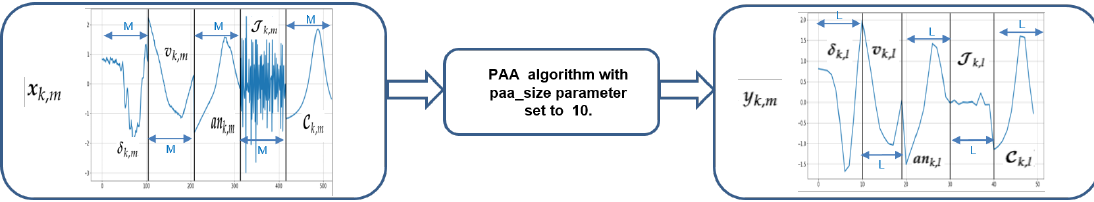
Figure 5. An example of the PAA algorithm applied on x k , m .